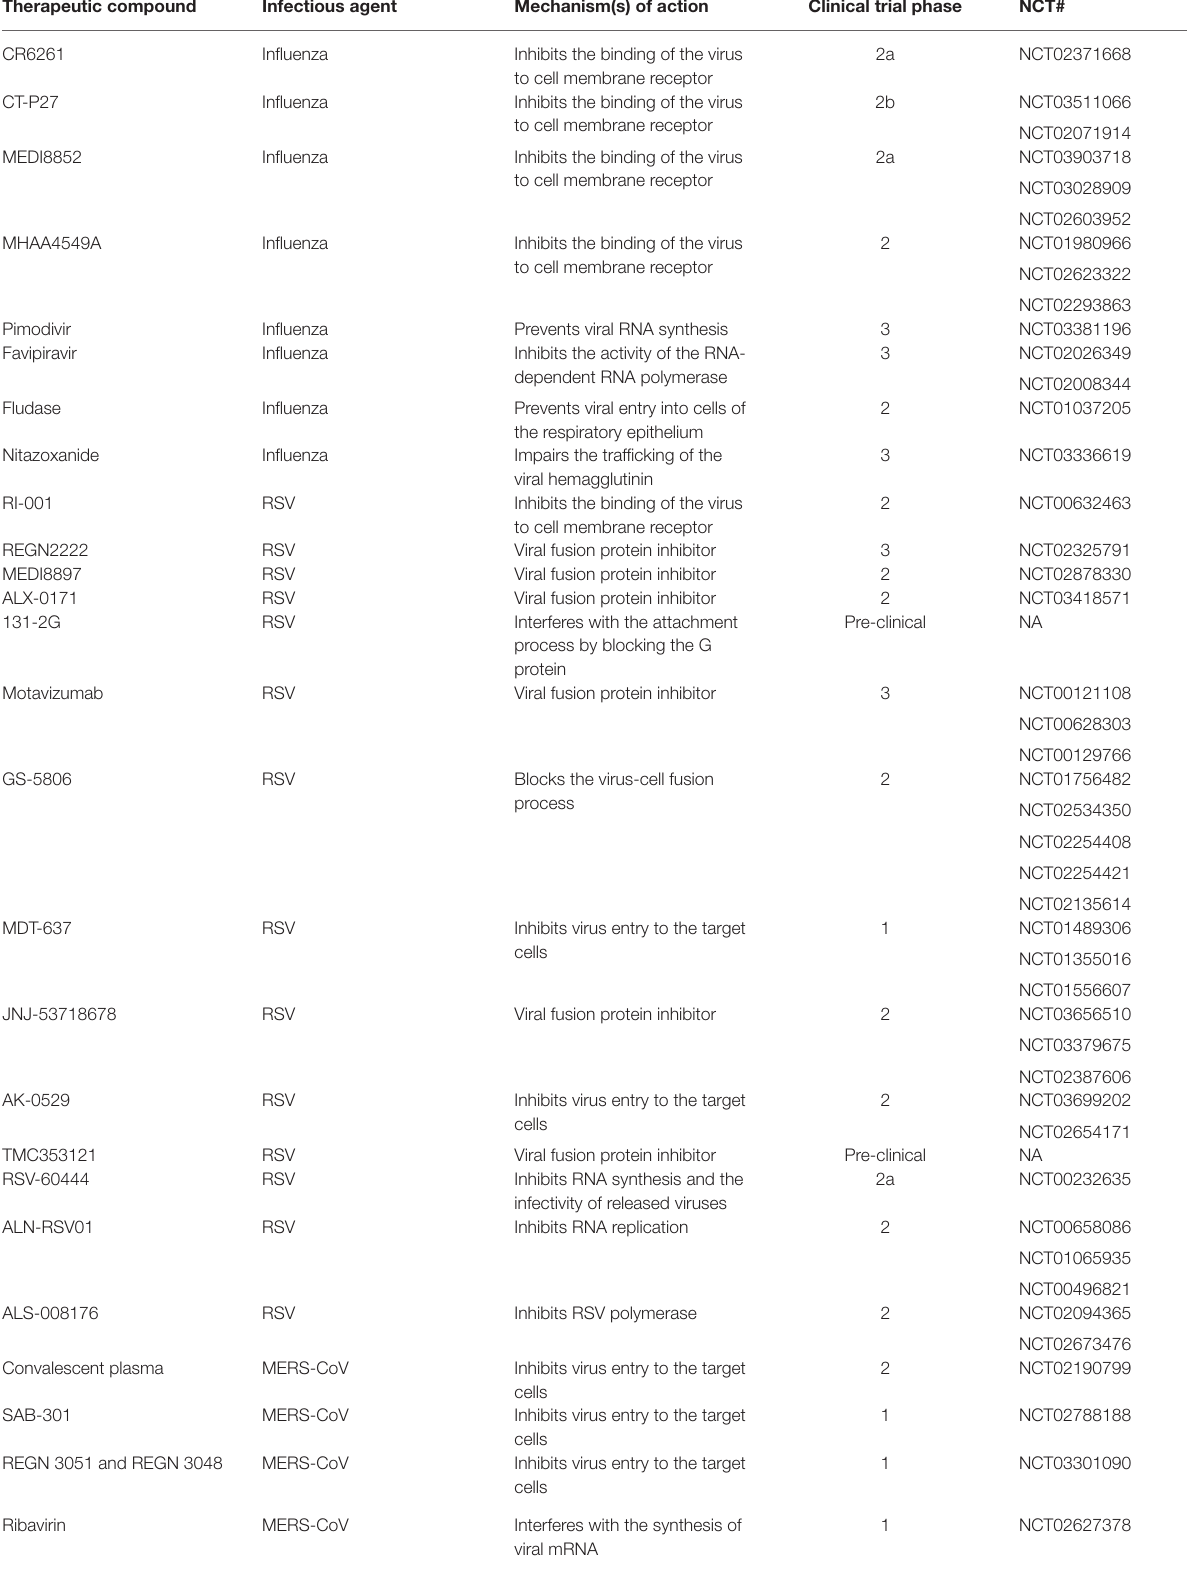
TABLE 1 | Novel therapeutics currently under development (clinical trials), for the treatment of influenza virus, respiratory syncytial virus (RSV), and Middle East respiratory syndrome coronavirus (MERS-CoV). Therapeutic